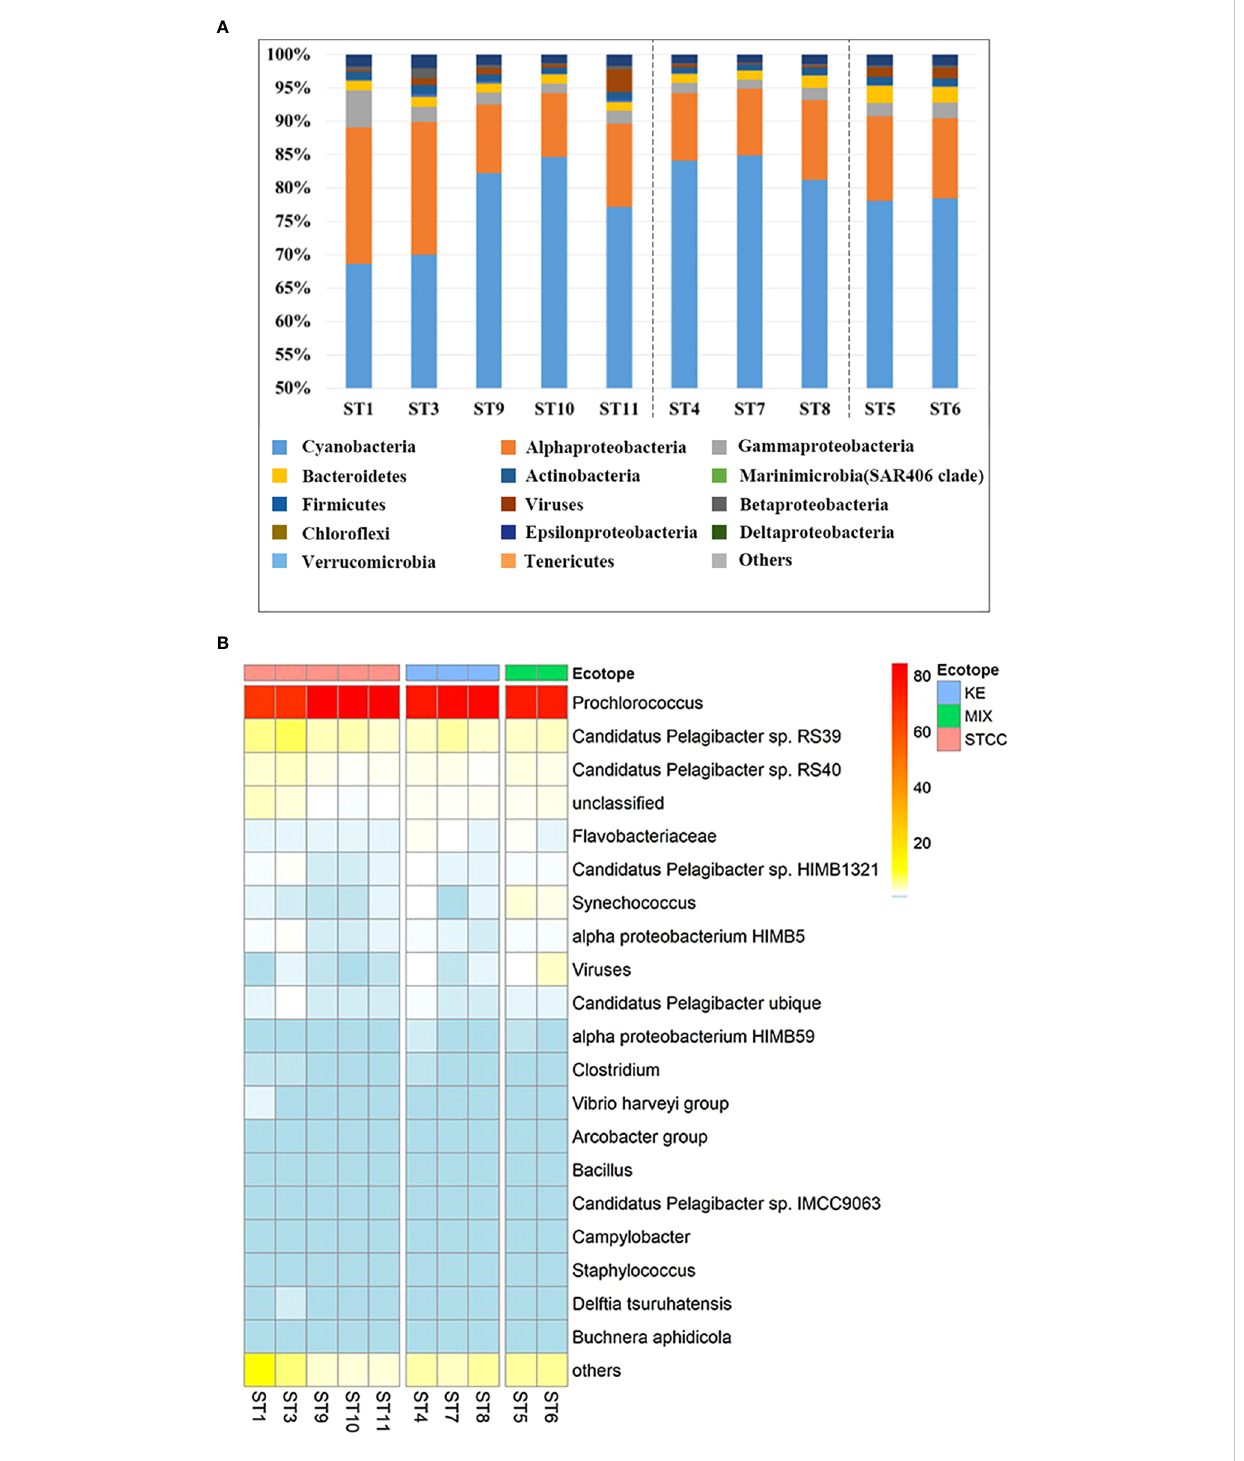
FIGURE 4 Relative abundance analysis of metagenomic sequences of ten sampling points in the NWPO surface layer during the summer cruise in 2018. (A) The histogram of the relative abundance of metagenomic sequences at the phylum level (proteobacteria for class level) and only the relative abundances of the top 15 phyla (class) were listed. (B) The heat map of relative abundance at the species level during the summer cruise in 2018 (only the relative abundances of the top 20 species are